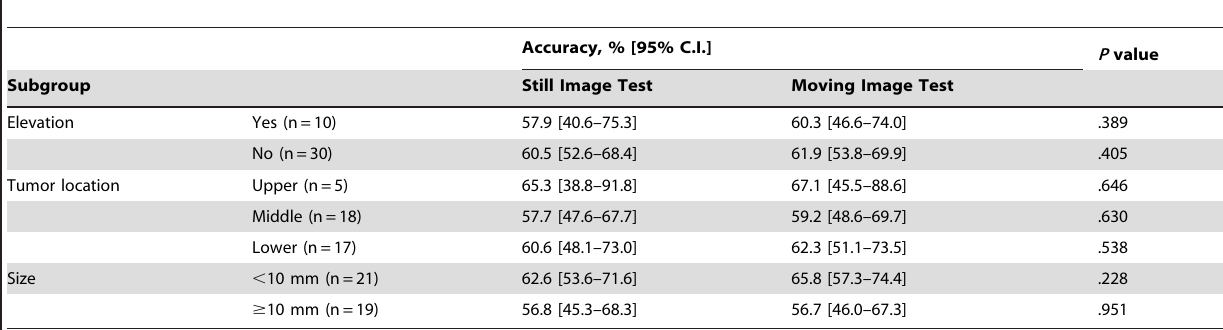
Table 6. Diagnostic Accuracy of Still Image Test versus Moving Image Test in the Subgroups of Endoscopic Findings.